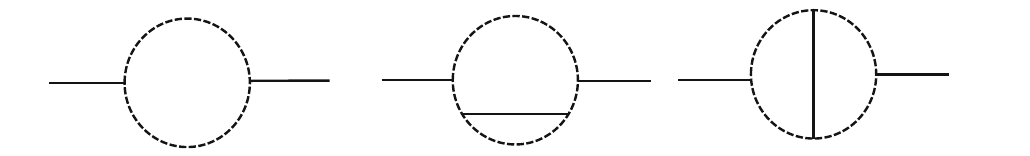
Fig. 1 Self energy diagrams for the scalar field at one and two loop order for the Yukawa coupling. The broken lines denote fermions whereas the solid lines denote the scalar. We shall restrict our computations to O ( g 2 ) only. See main text for